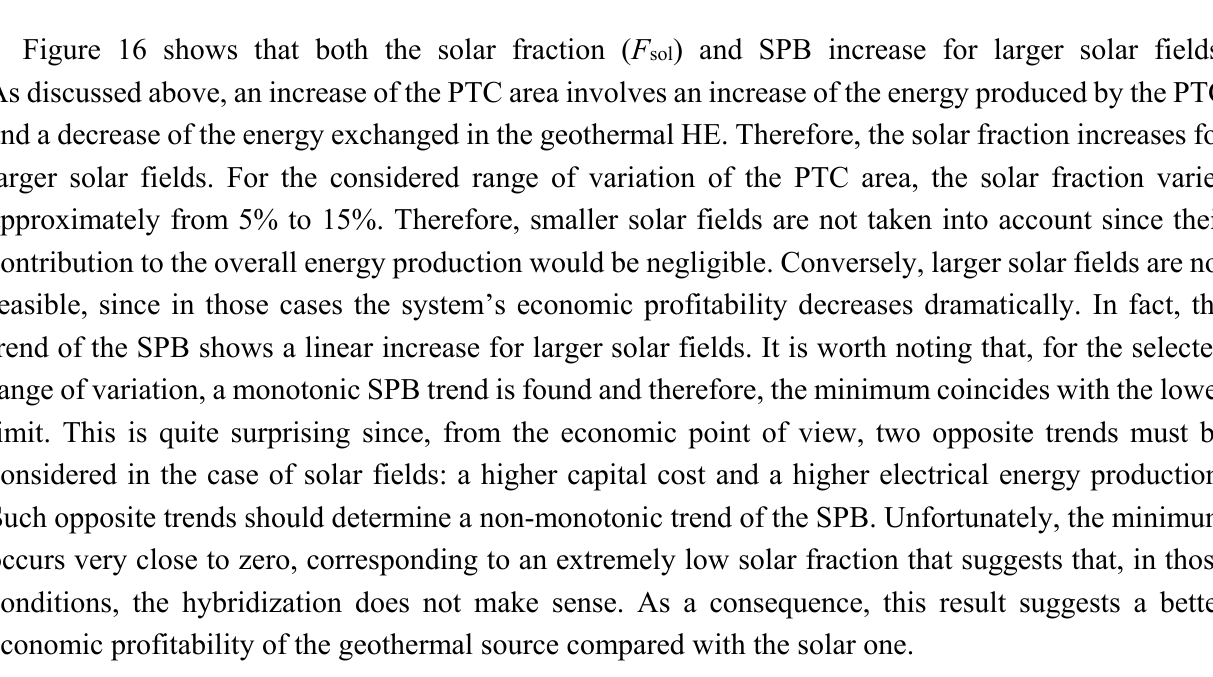
Figure 15. Efficiencies and exergy destruction by varying the collector